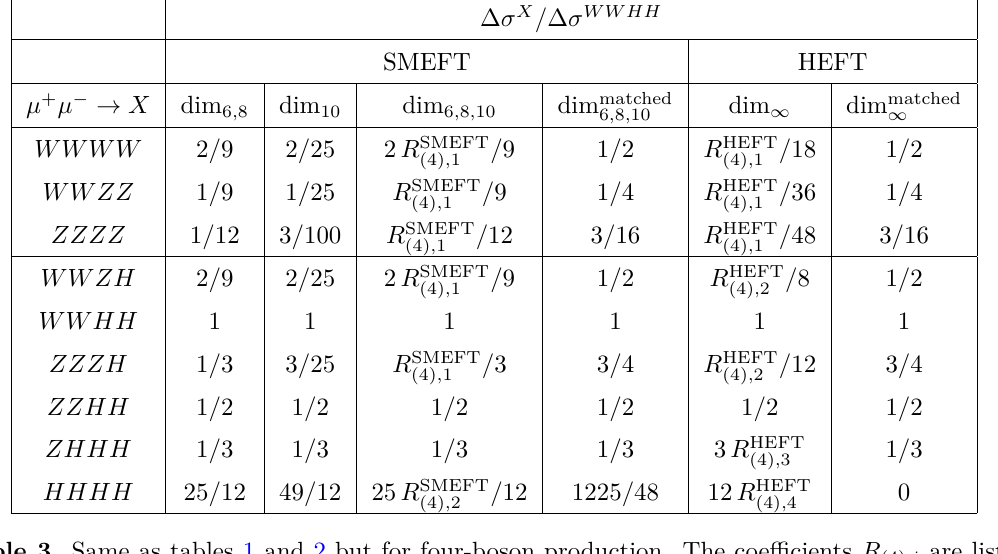
Table 3 . Same as tables 1 and 2 but for four-boson production. The coefficients R in